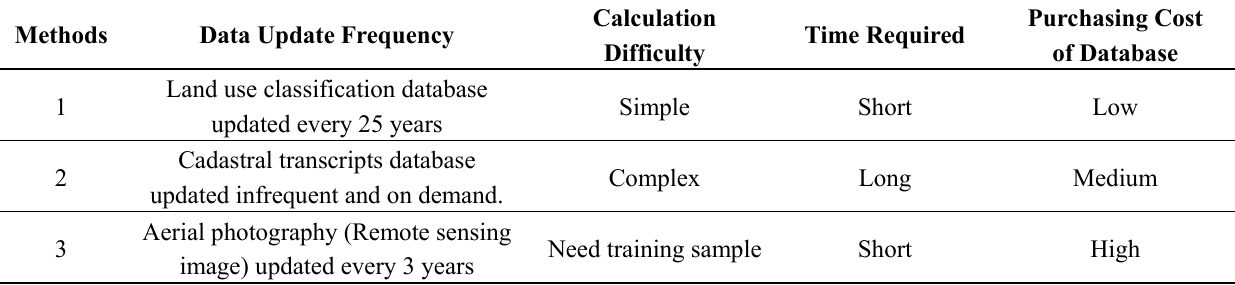
Table 1. Comparison among three different methods for selected items.